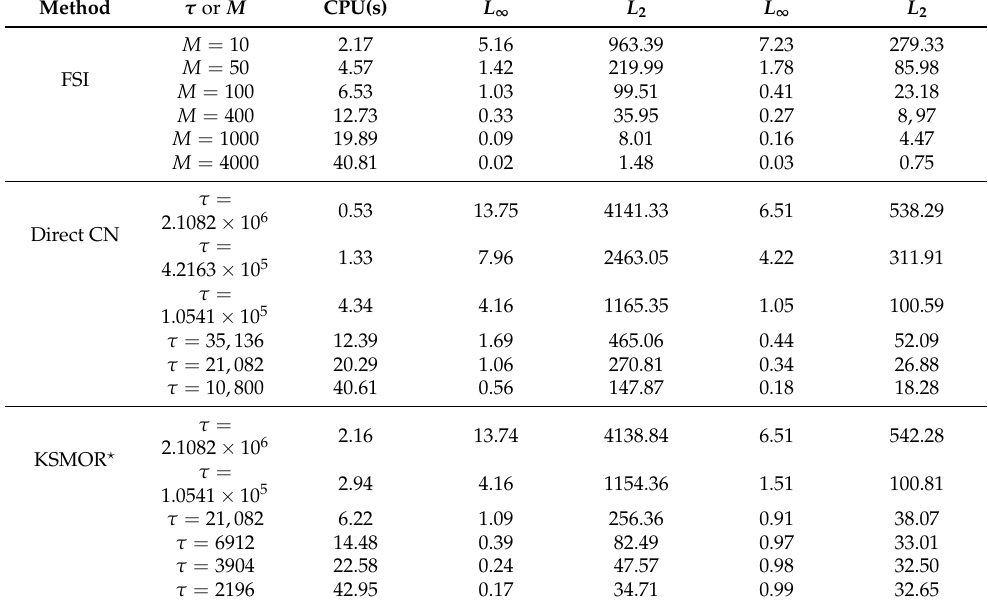
Table A3. Results of the GES experiment with real data: evaluation of the accuracy and the corre- sponding CPU time between FSI, direct CN and KSMOR (cid:63) with q = 2, s = 10. The parameters are fixed to t F = 21 10 6 and h = 0.04 ( N = 100,701 grid points). Special care should be taken because × the errors presented with respect to L ∞ and L 2 are evaluated in two ways: errors evaluated along the temporal axis ( middle ) and at the stopping time t F ( right ) for temperature probe B1 (3rd from the top) and the entire simulation domain, respectively. The reference solution is computed with